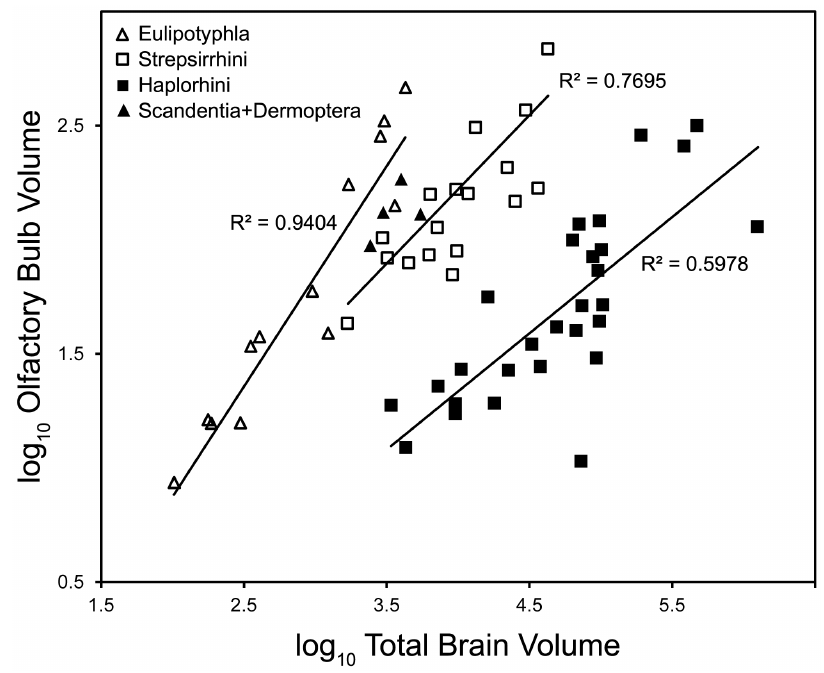
Figure 1. Scatter plot of log transformed OB and TB volumes. Data points are observed values. Regression lines are PGLS linear models based on extant taxa from the strepsirrhine, haplorhine and eulipotyphlan clades. Scandentia + Dermoptera do not contribute to regressions.